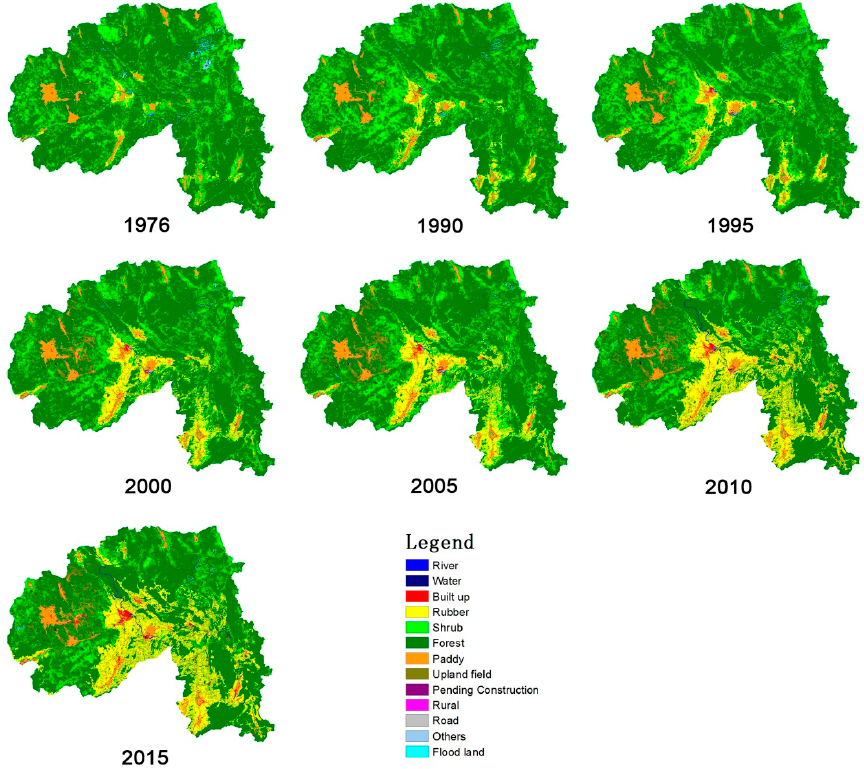
Figure 3. Land use maps from 1976 to 2015.